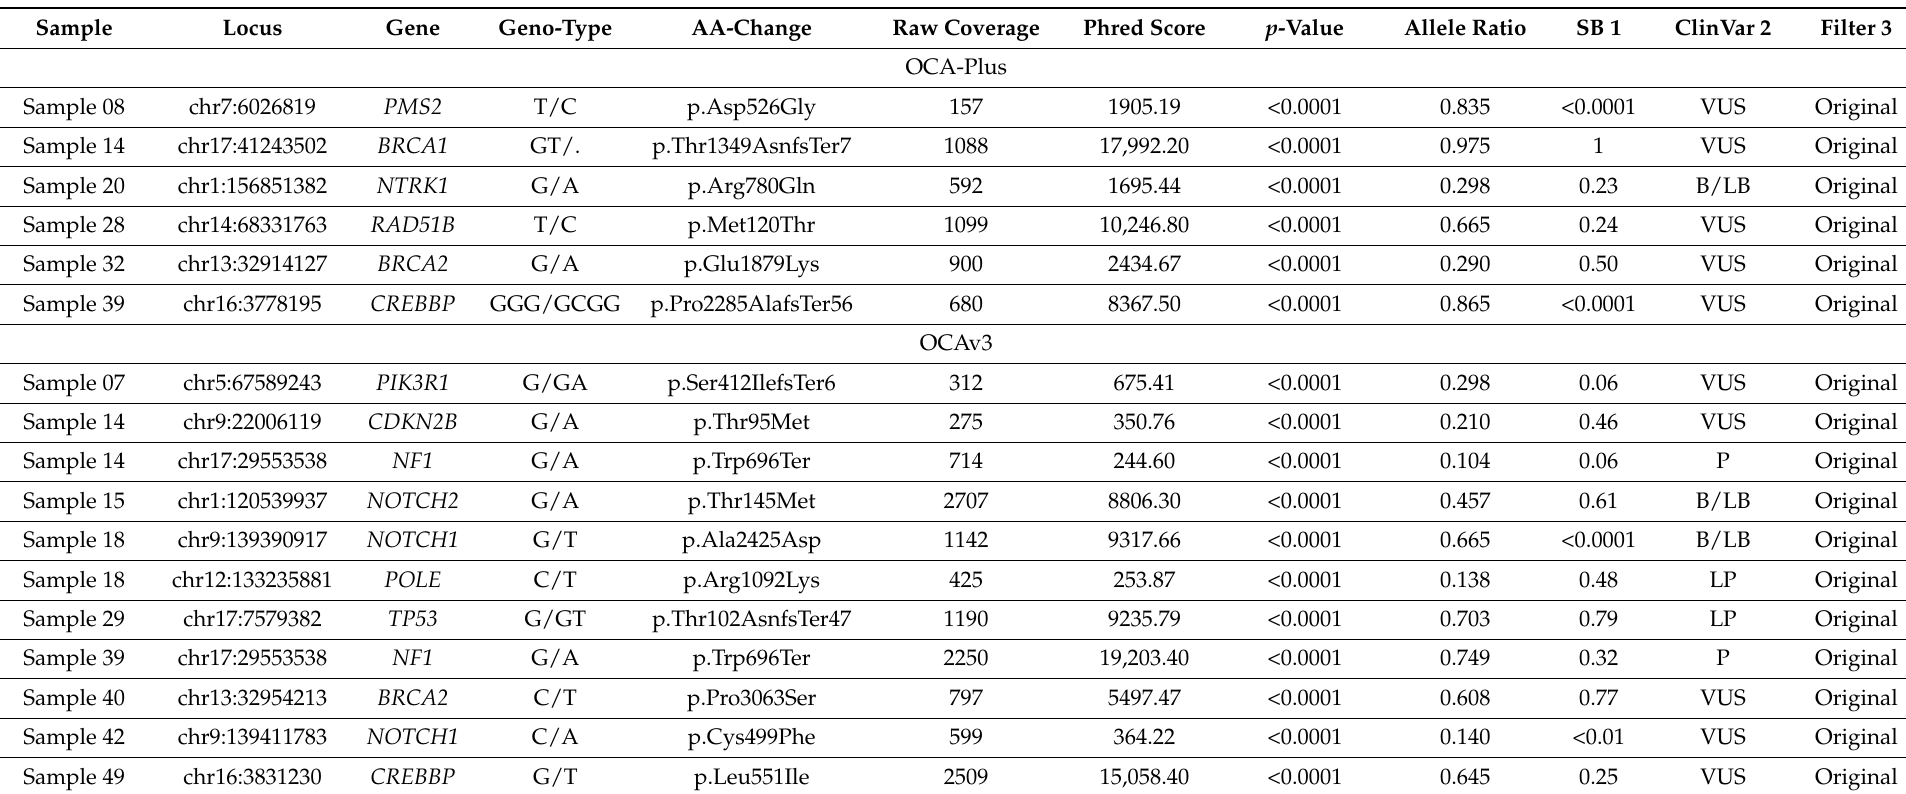
Table 6. Disconcordant